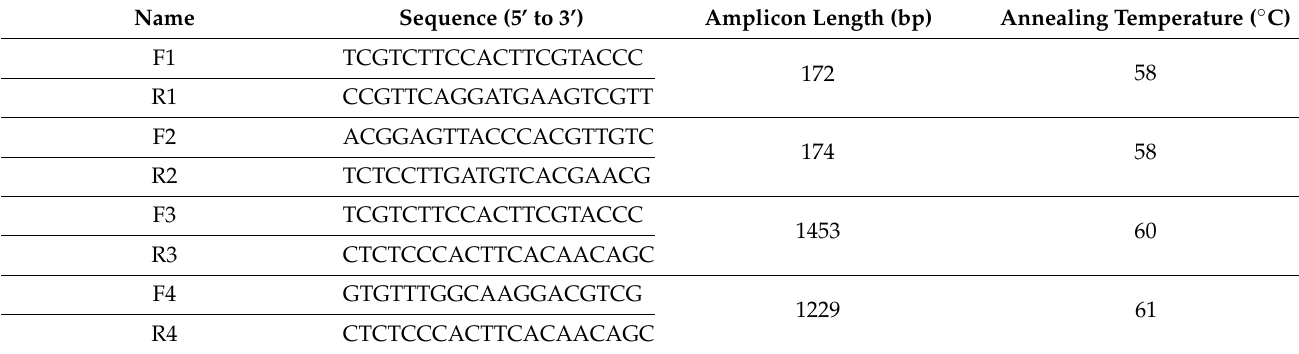
Table 1. List of primers used in this study. Primer pairs F1-R1 and F2-R2 were used for copy number variation as well as gene expression analysis. Primer pairs F3-R3 and F4-R4 were used to isolate and clone partial Cyp51 gene from Cercospora beticola